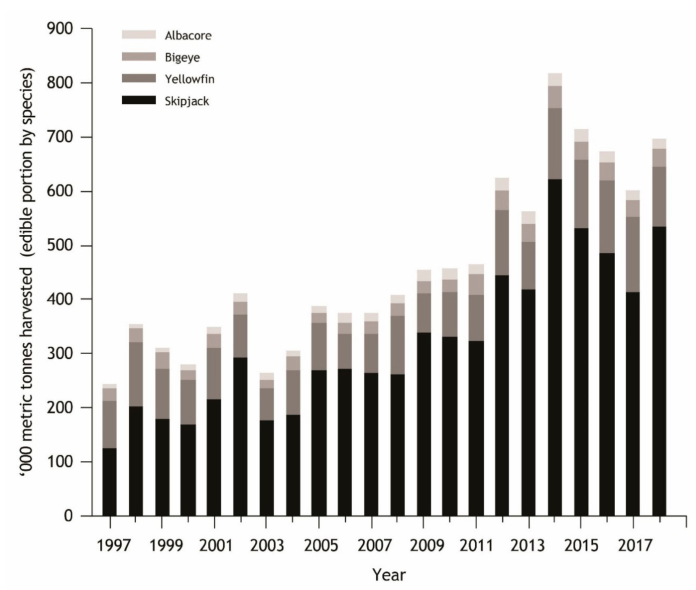
Figure 4. Temporal trend in total edible portion of registered catch (1997–2018) within PICT (same PICTs asFigure3)nationalwaters. TotalcatchwascalculatedasthetotalcatchofAlbacore, Bigeye, Skipjackand Yellowfin tuna by domestic and foreign-flagged vessels multiplied by 0.58 [53] to derive a measure of edible harvest. Tuna data from Pacific Islands Forum Fisheries Agency (https: // www. ff a.int / catch_value). Human population data from UN Population division (https: // www.un.org / development / desa / pd /